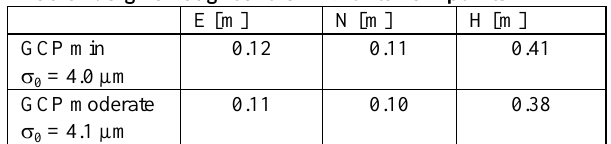
Table 7: Sigma naught and SDEV of terrain points